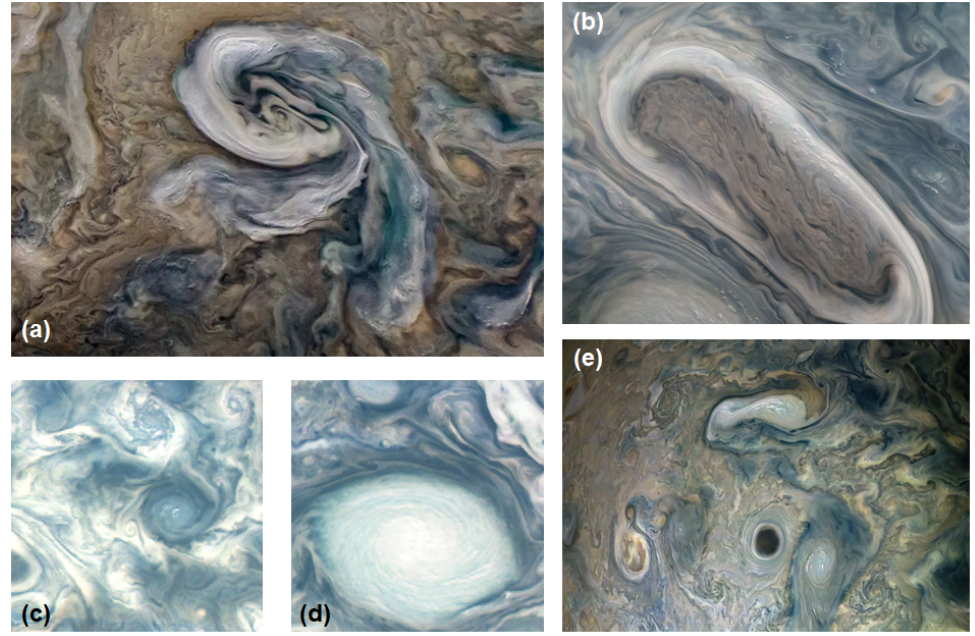
Figure 4. Survey of pop-up clouds in different environments from JunoCam observations. These clouds are indicative of localized convection in ammonia cloud deck. Image credits: ( a , b ) NASA/JPL-Caltech/SwRI/Kevin M. Gill, ( c , d ) NASA/JPL-Caltech/SwRI/R. Sankar/( e ) NASA/JPL- Caltech/SwRI/Gerald Eichstädt/Seán